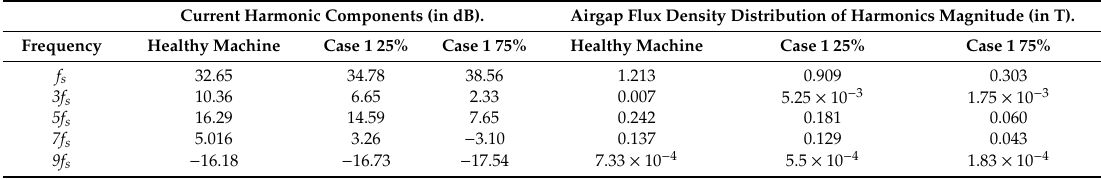
Table 1. Current harmonic components comparison and airgap flux density distribution of harmonics magnitude variations due to case 1.